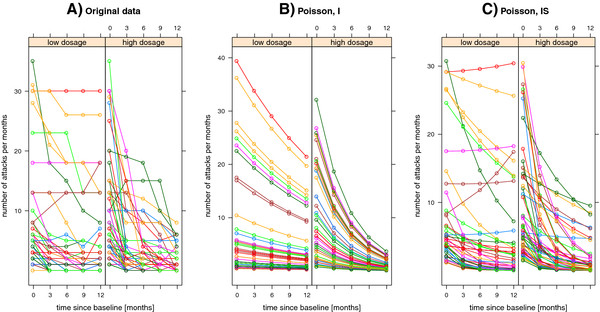
Trajectory plots for vertigo data. Effect of betahistine-dihydrochloride on the frequency of attacks of vertigo in a total of 112 Menière’s disease patients; 2 treatment groups: “low-dosage” (50 patients) vs. “high-dosage” (62 patients). A) individual trajectories for vertigo data. B) and C) display the conditional posterior mean trajectories of the number of attacks depending upon fixed and random effects after fitting a Poisson GLMM (I: model with random intercepts. IS: model with random intercepts and slopes). The same color is used to indicate observations and model-based estimates for the same patient.